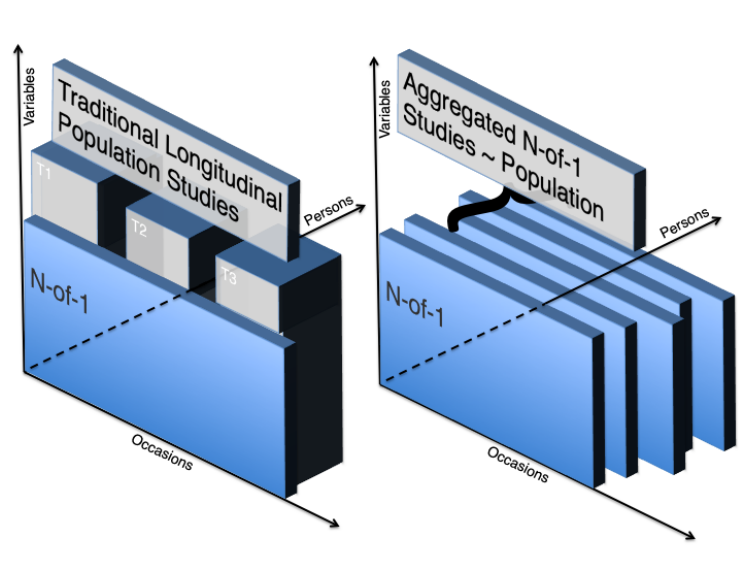
Figure 1: Traditional Longitudinal Population Studies versus